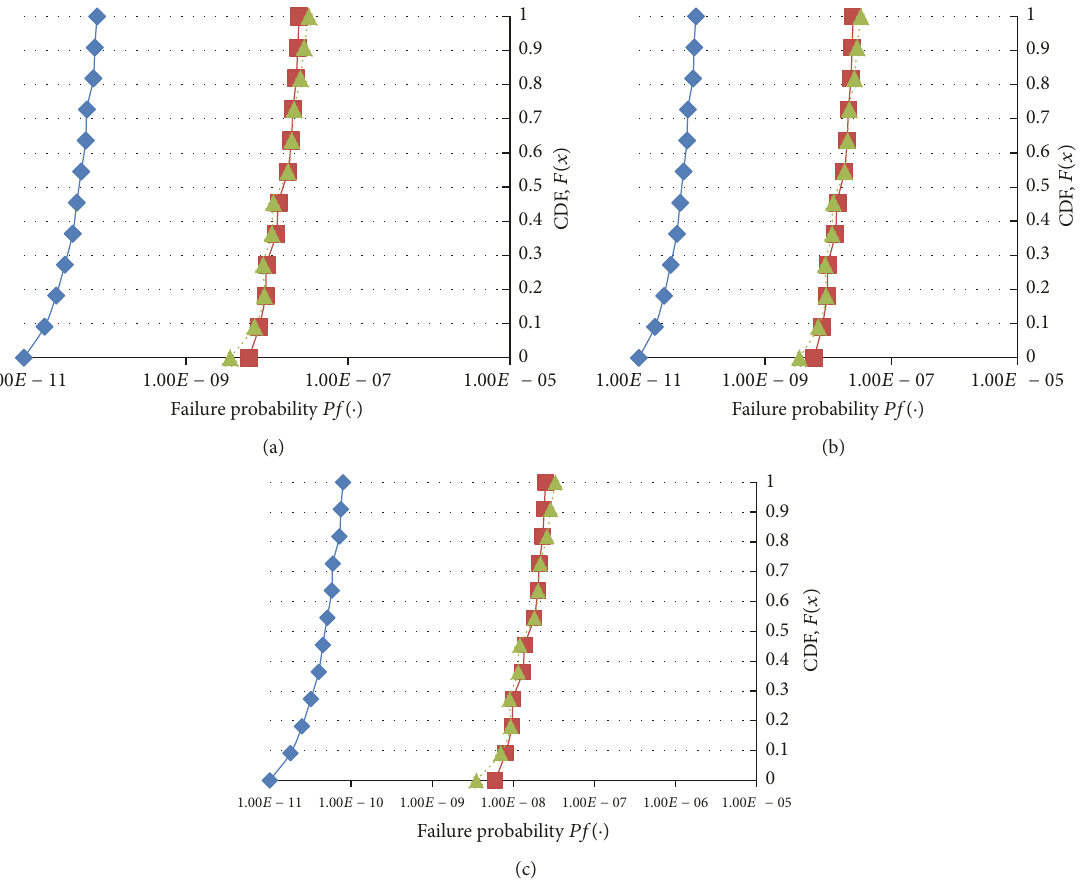
Figure 19: Comparison of Monte Carlo simulated P-box (solid line) and interval analysis P-box (dotted line) (a) Gamma model. (b) Lognormal model. (c) Weibull